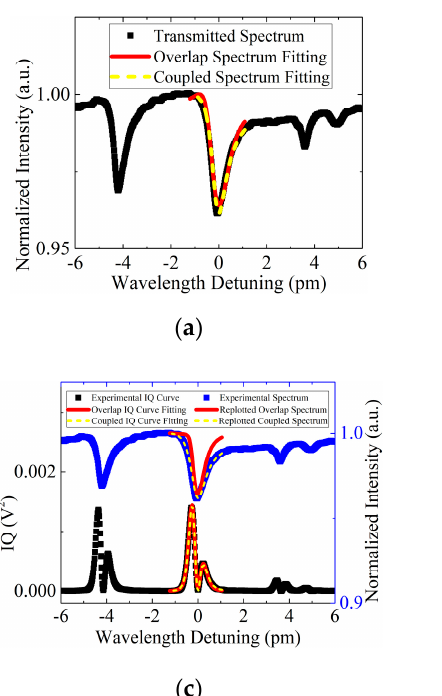
Figure 3b IQ. 2 ( g ≠ 0) Figure 3b IQ. ( g = 0) 1 Res., Resonance. 2 IQ., IQ curve. 3 FCOD, Fitting coefficient of determination (Fitting R-Square). 4 RCOD, Replotted coefficient of determination (Replotted R-Square).